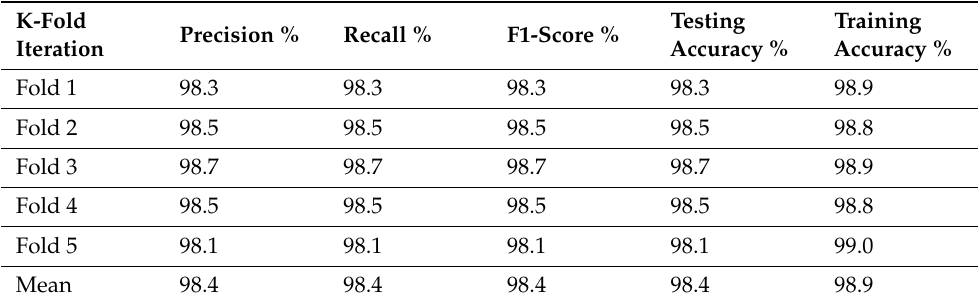
Table 5. The results of the SVM classifier using five-fold cross-validation. K-Fold Iteration